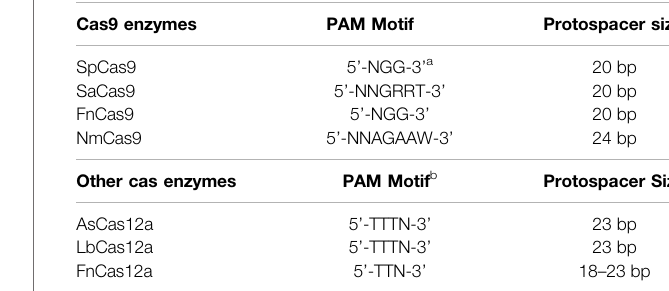
TABLE 2 | Comparison of Different Cas9 and Cas12a Genome Editing